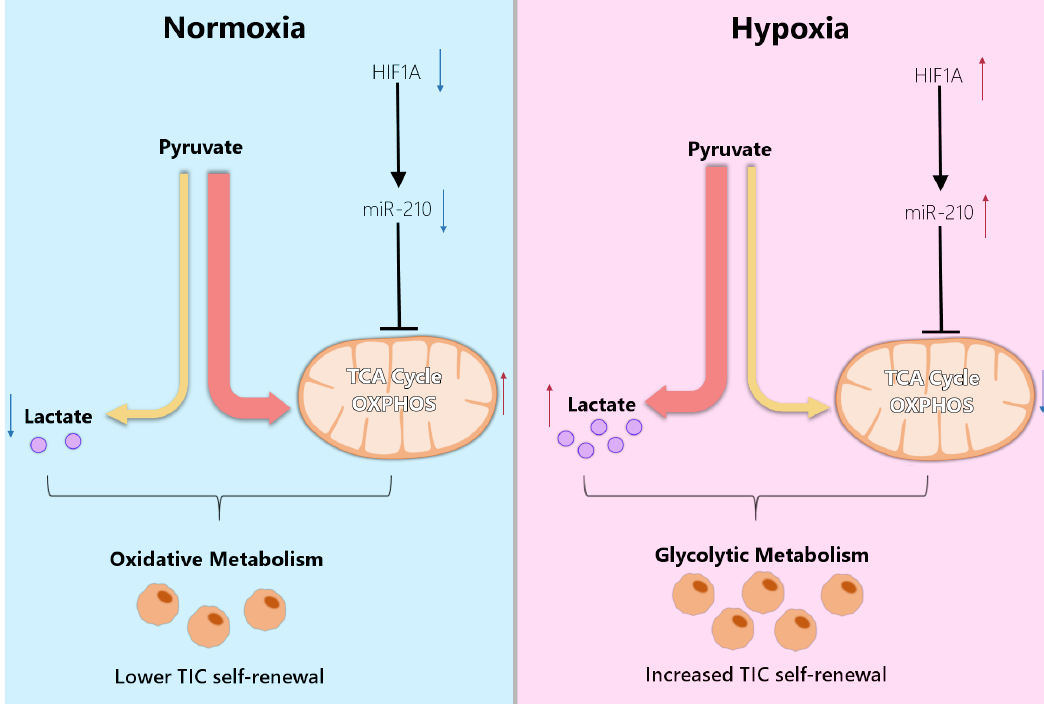
Figure 2. Hypoxia-responsive miR-210 drives the metabolic reprogramming and self-renewal activity of TICs. HIF1A-induced expression of miR-210-3p results in reduced TCA cycle activity and repressed oxidative phosphorylation under hypoxic conditions. The resulting metabolic shift leads to increased lactate production and drives cancer progression by promoting the self-renewal capacity of